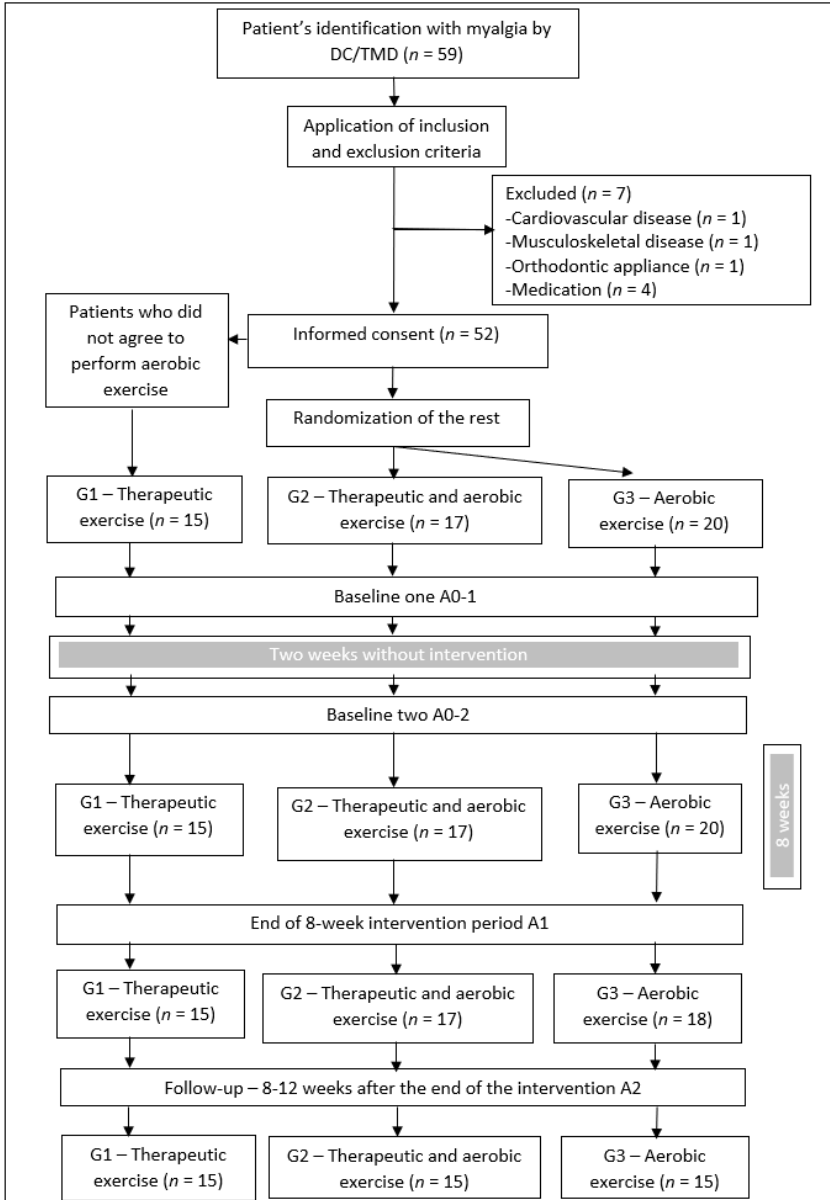
Figure 1. Study design flow chart.